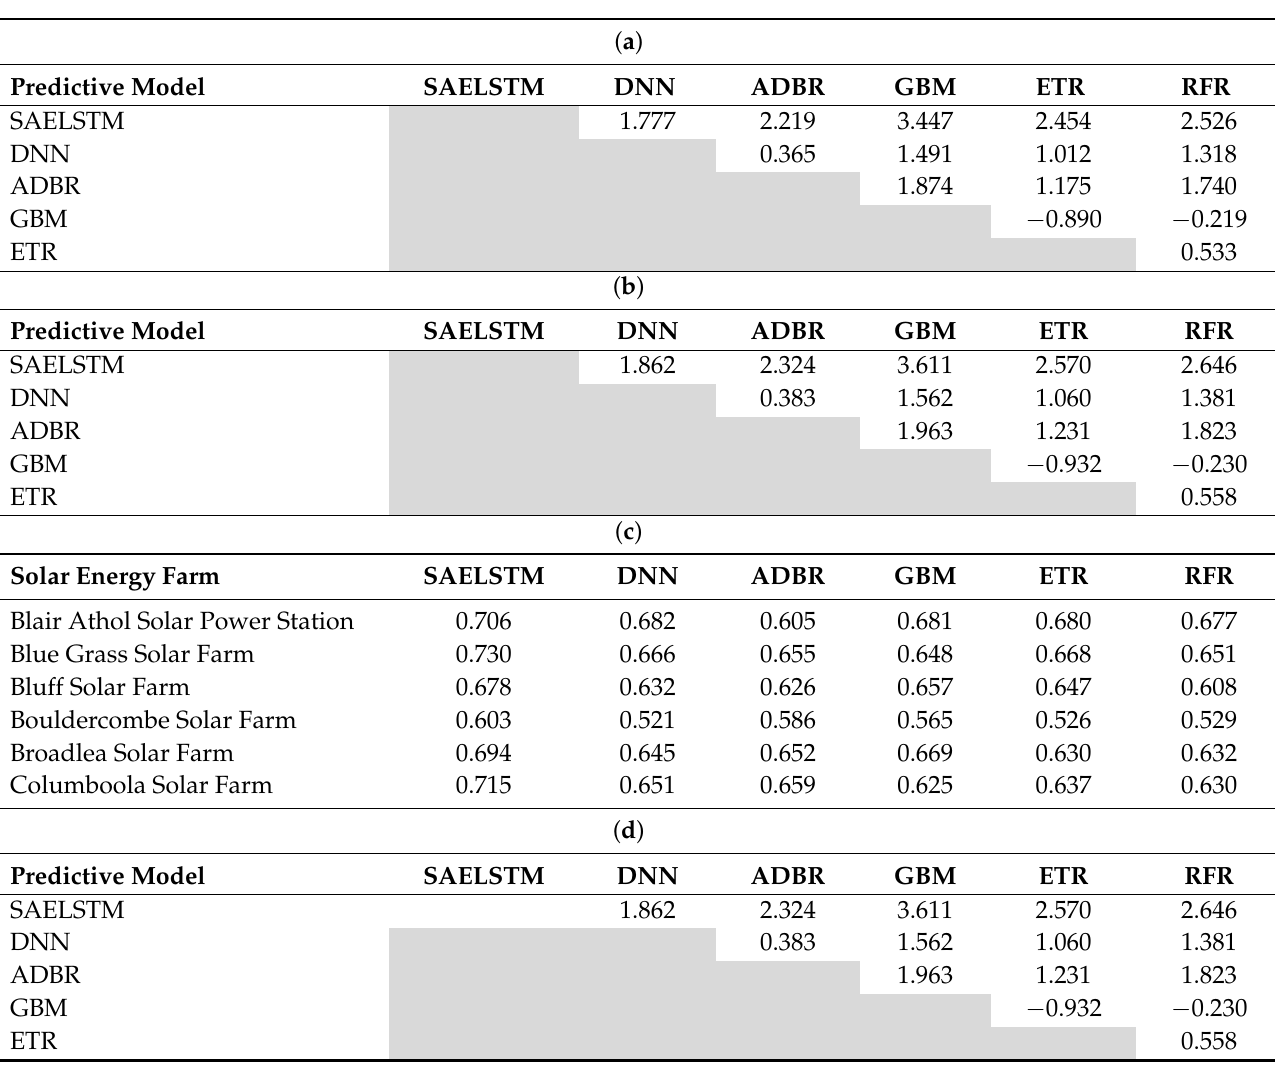
Table 9. ( a ) Diebold–Mariano (DM) test statistics. To interpret this, we compare the column of the table with rows. For a positive result, the model in the column would be superior and with a negative result, the model in the row is superior. ( b ) Harvey, Leybourne, and Newbold statistics. ( c ) The Skill Score Metric (SS) for the proposed Deep Learning hybrid SAELSTM, as well as other Deep Learning and comparative models. ( d ) The performance of the proposed Deep Learning hybrid SAELSTM model with comparative benchmark models measured by the ratio of the root mean square error